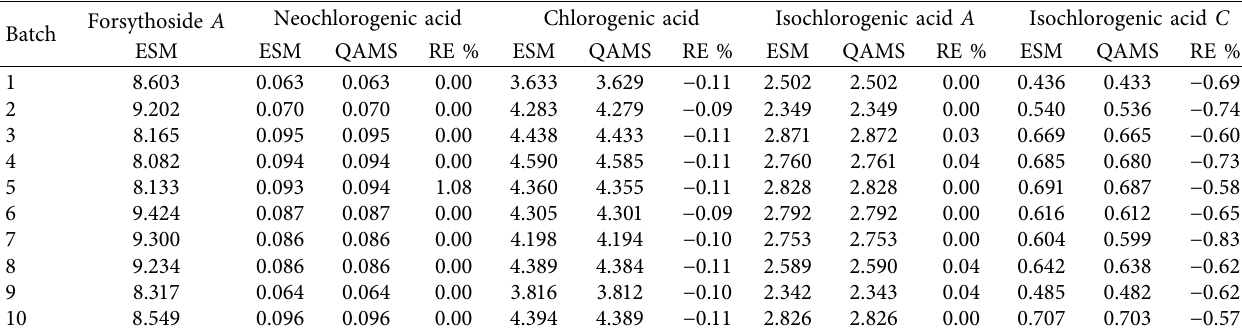
Table 9: Te calculation results of the ESM and QAMS method at 327nm.